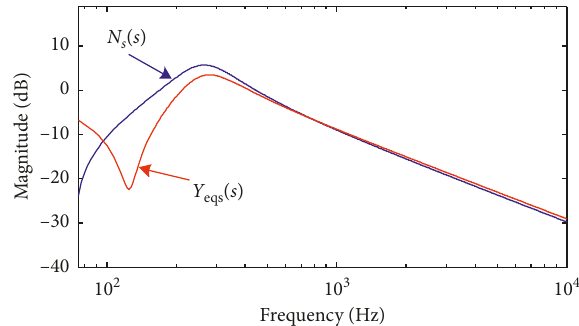
Figure 8: Magnitude-frequency curves of N